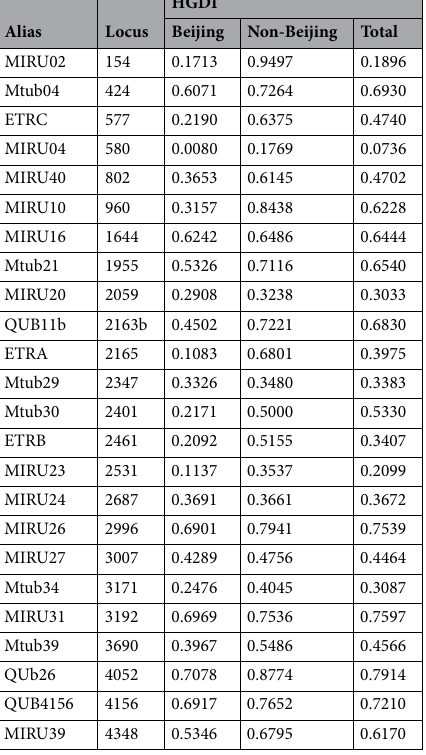
Table 4. The diversity of each of the 24 MIRU-VNTR loci in Beijing (n = 249) and Non-Beijing (n = 150) Mycobacterium tuberculosis isolates from